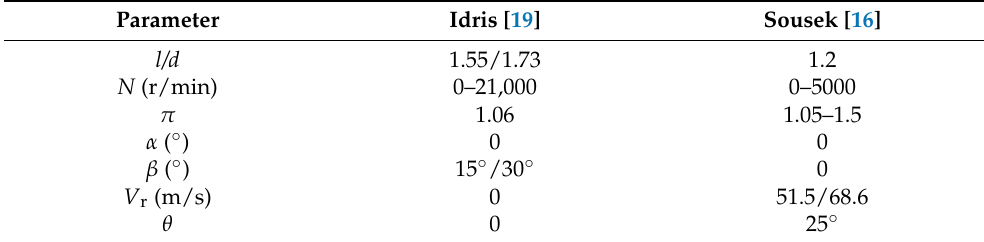
Table 4. Main parameters of the orifices in different literature.